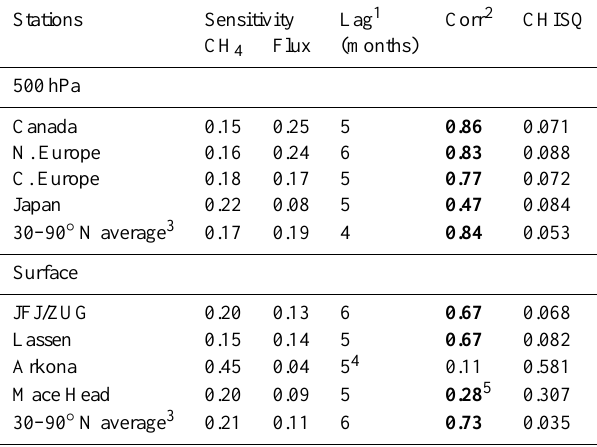
Table 3. Sensitivity coefficients (percent change in ozone to per- cent change in CH 4 or the 100hPa ozone flux) between 12-month smoothed normalized simulated ozone with normalized globally av- eraged methane and the normalized lagged 30–90 ◦ N ozone flux at 100hPa. Coefficients are given for the lag with the smallest chi squared. Variables are normalized by their average value from 1980 to 1985.